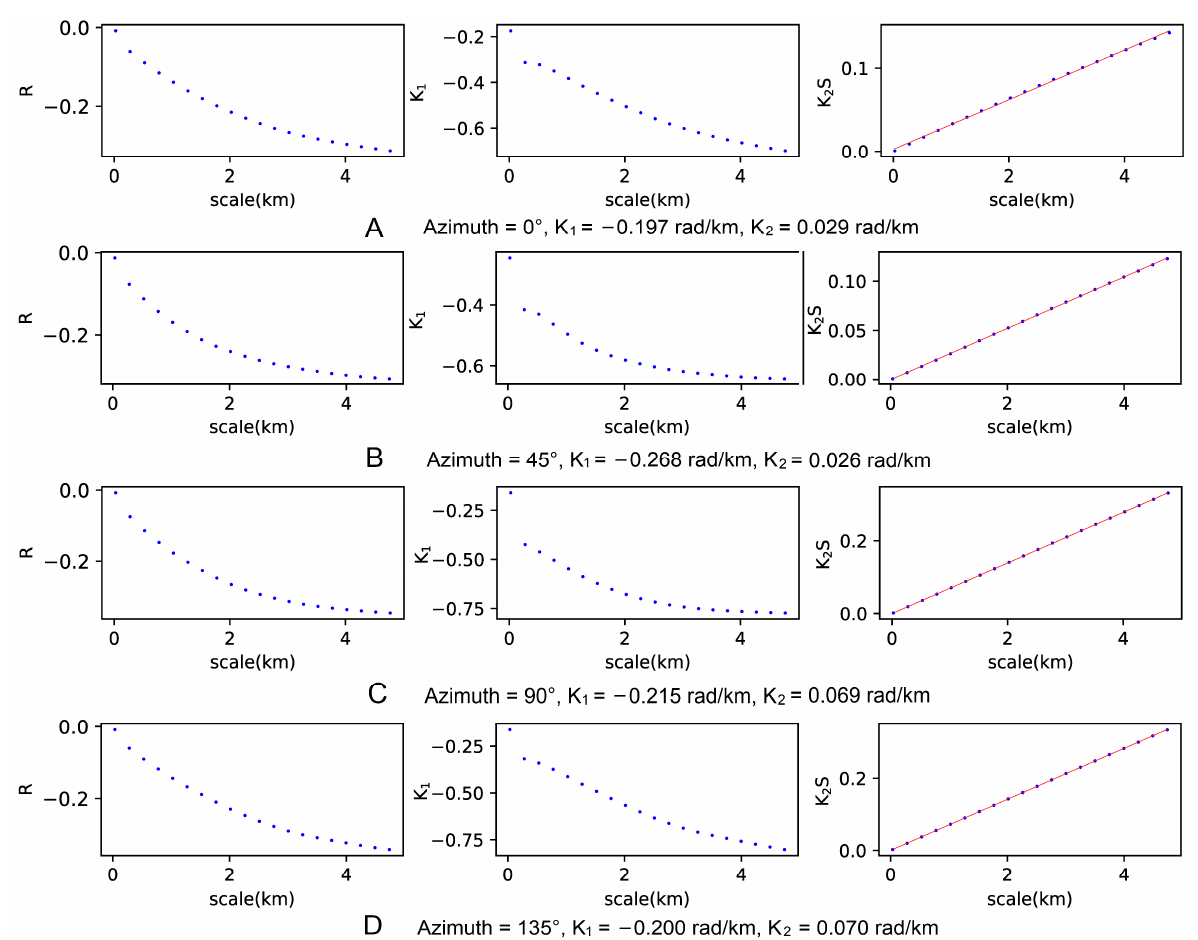
K K S Figure 7. The values of the correlation coefficient R (column 1), K 1 (column 2), and K 2 S (column 3, Figure 7. The values of the correlation coe ffi cient R (column 1), 1 (column 2), and 2 (column blue dots, the red line is the fitting line of the blue dots) after the difference of the interferogram 3, blue dots, the red line is the fi tt ing line of the blue dots) after the di ff erence of the interferogram in four directions, and the final K 1 , estimated according to the method described in the text. The K in four directions, and the fi nal 1 , estimated according to the method described in the text. The maximum absolute value of K 2 is 0.070 rad/km ( D ), the corresponding azimuth is 135 ◦ , and the K related K 1 is − 0.200 rad/km. The K 2 values of other azimuth ( A – C ) are all less than 0.070 maximum absolute value of 2 is 0.070 rad/km ( D ), the corresponding azimuth is 135°, and the K K related 1 is − 0.200 rad/km. The 2 values of other azimuth ( A – C ) are all less than 0.070 rad/km.